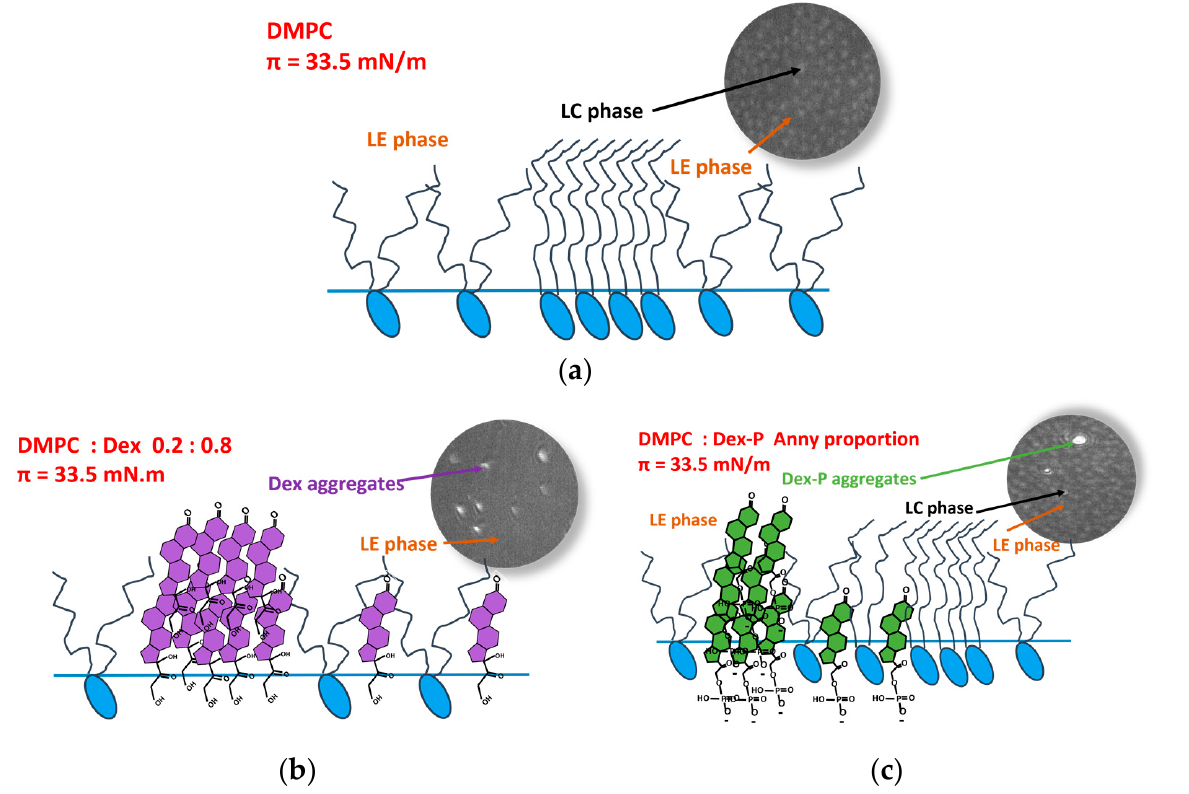
Scheme 2. Schematic representation of ( a ) pure DMPC in the LE and the LC phase. ( b ) DMPC: Dex 0.2:0.8, Dex mixed with DMPC in the LE phase and Dex aggregates. ( c ) DMPC: Dex-P 0.2:0.8, Dex-